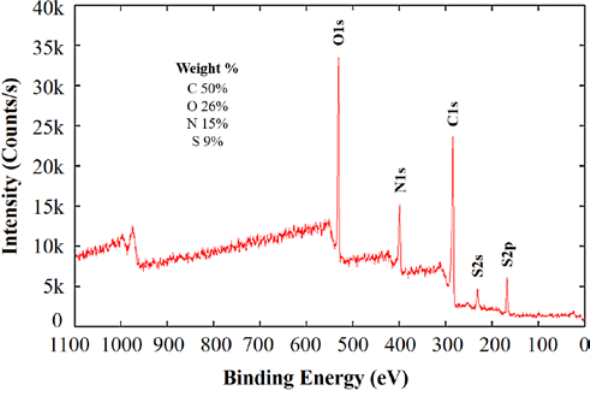
Figure 3. X-ray photoelectron spectroscopy (XPS) survey spectrum of NSPC foam.